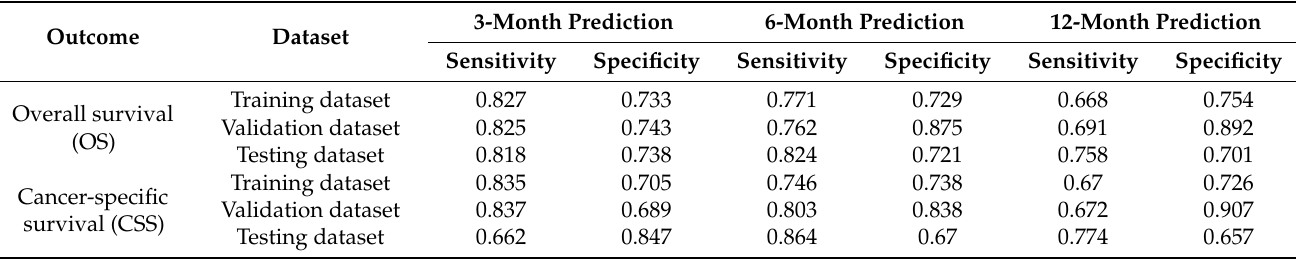
Table 2. Sensitivity and specificity to assess the performance of the